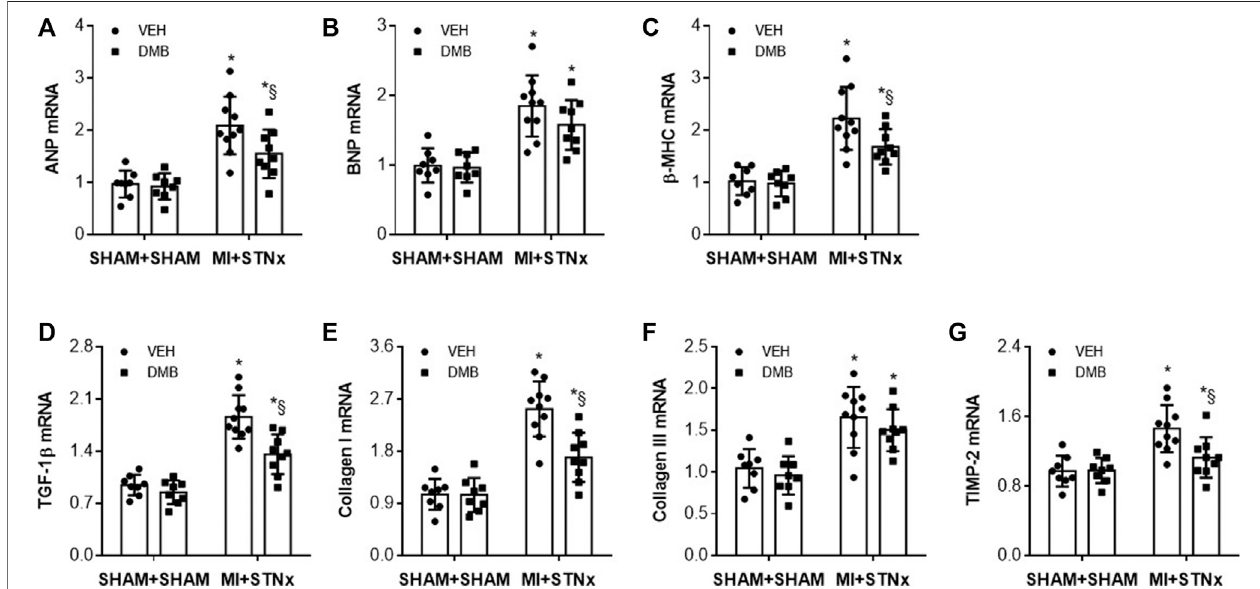
FIGURE 6 | Effects of CRS2 and DMB treatment on gene expression of pro-hypertrophic markers ANP (A) , BNP (B) and β -MHC (C) and on gene expression of pro- fi brotic markers TGF- β 1 (D) , Collagen-I (E) , collagen-III (F) and TIMP-2 (G) in the heart. Data are expressed as mean ± SE ( n (cid:1) 8 – 10 for each group). * p < 0.05 vs SHAM + SHAM + VEH; § p < 0.05, MI + STNx + DMB vs MI + STNx + VEH.